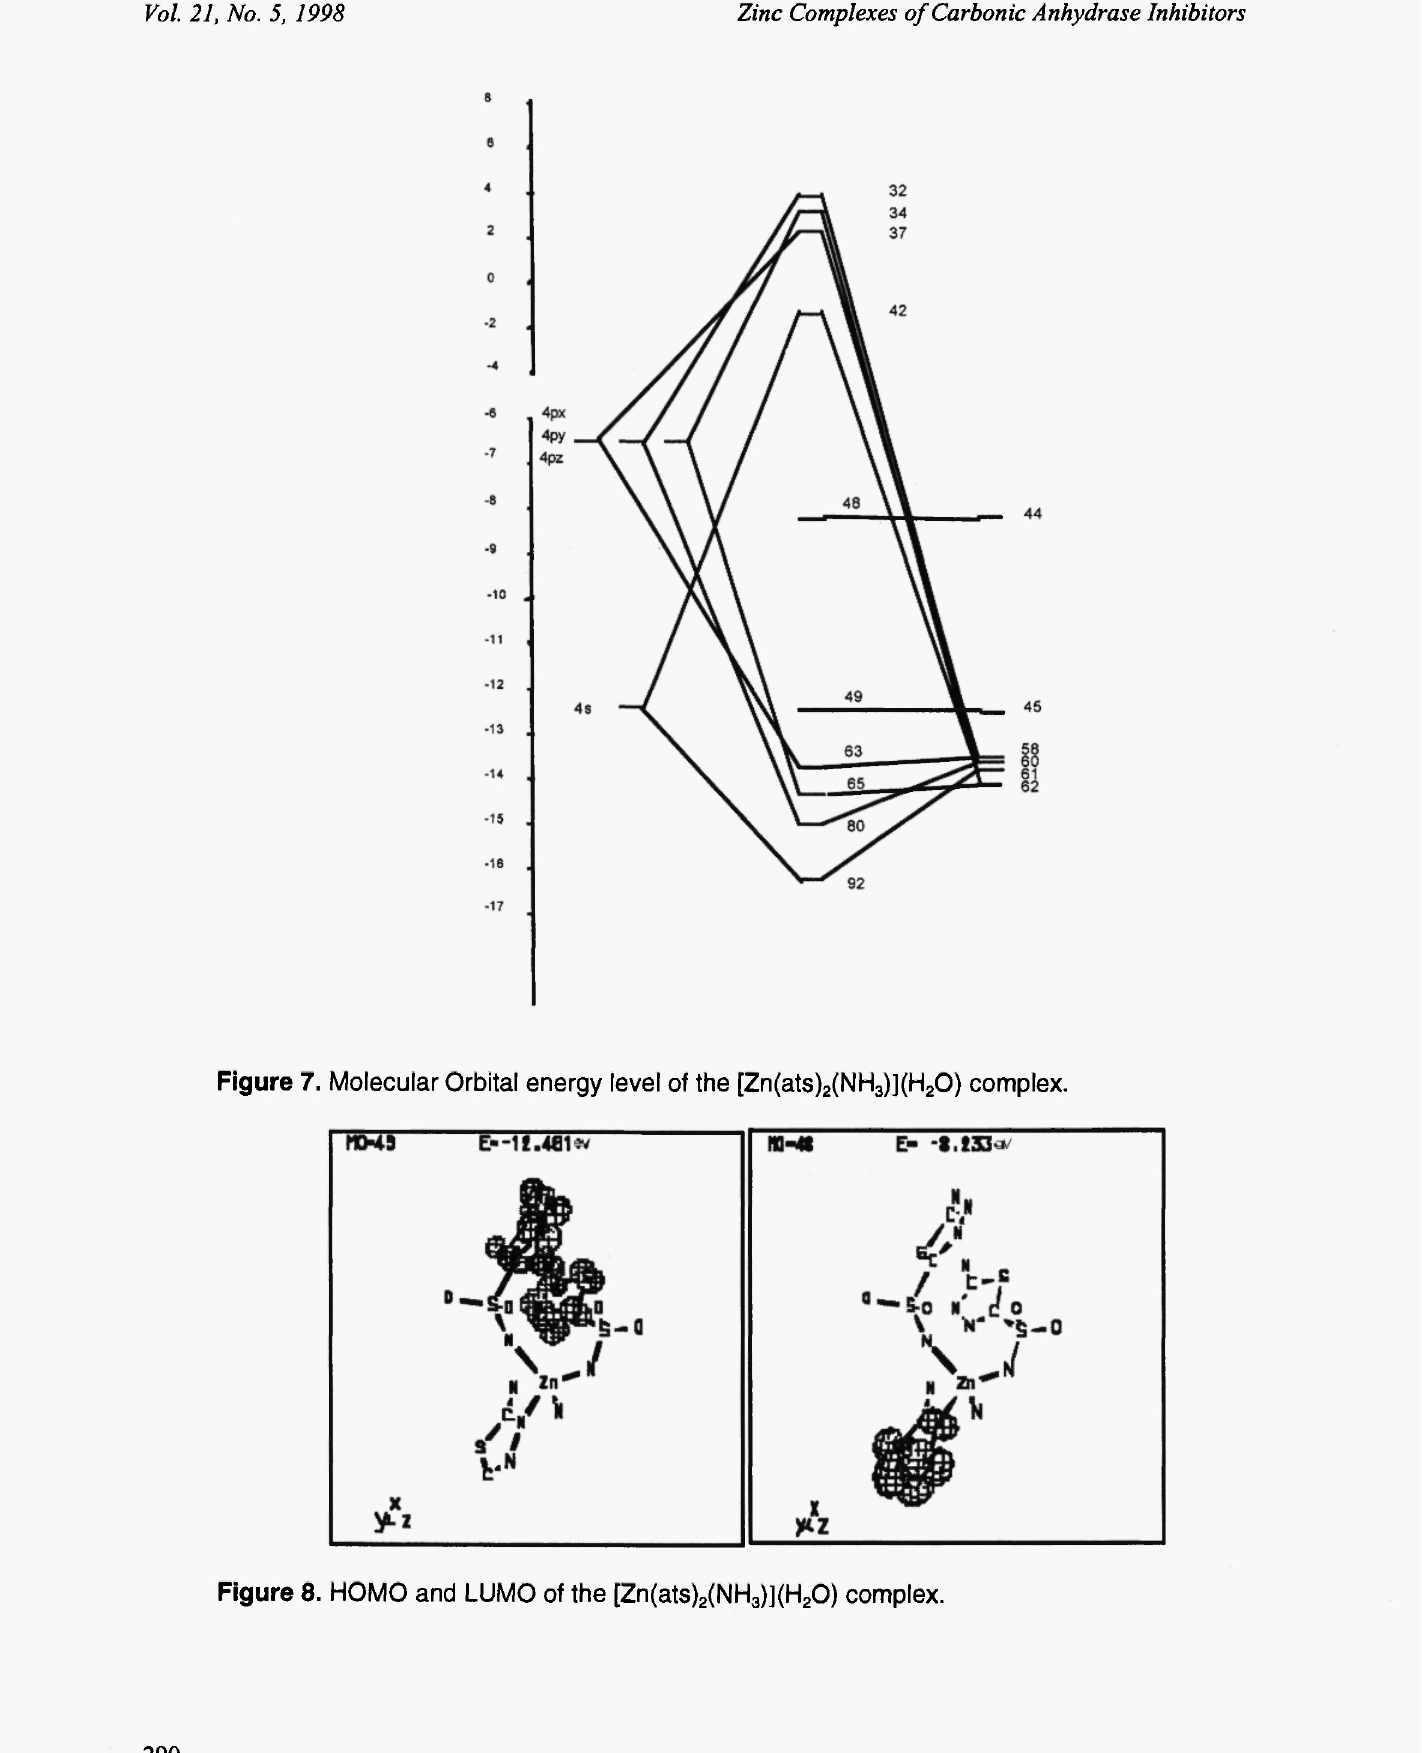
Figure 8. HOMO and LUMO of the [Zn(ats) 2 (NH 3 )](H 2 0) complex.